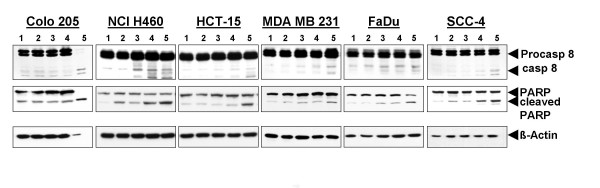
Westernblot analysis of Caspase-8 activation and PARP-cleavage. Lysates were prepared as described in methods. In six tumour cell lines(Colo 205, NCI H460,, HCT-15, MDA MB 231, FaDu and SCC-4) caspase-8 and PARP cleavage was analysed in untreated cells (lane 1), 24 h after treatment with TRAIL 0,1 ng/ml (lane 2) and 10 Gy alone (lane 3), after simultaneous (lane 4) and sequential application (lane 4) of combined therapy. Every cell line shows a different cleavage pattern according to the rate of apoptosis induction. β-Actin staining was used as loading control. The mapped blots represent each one of three independently performed immunoblots.